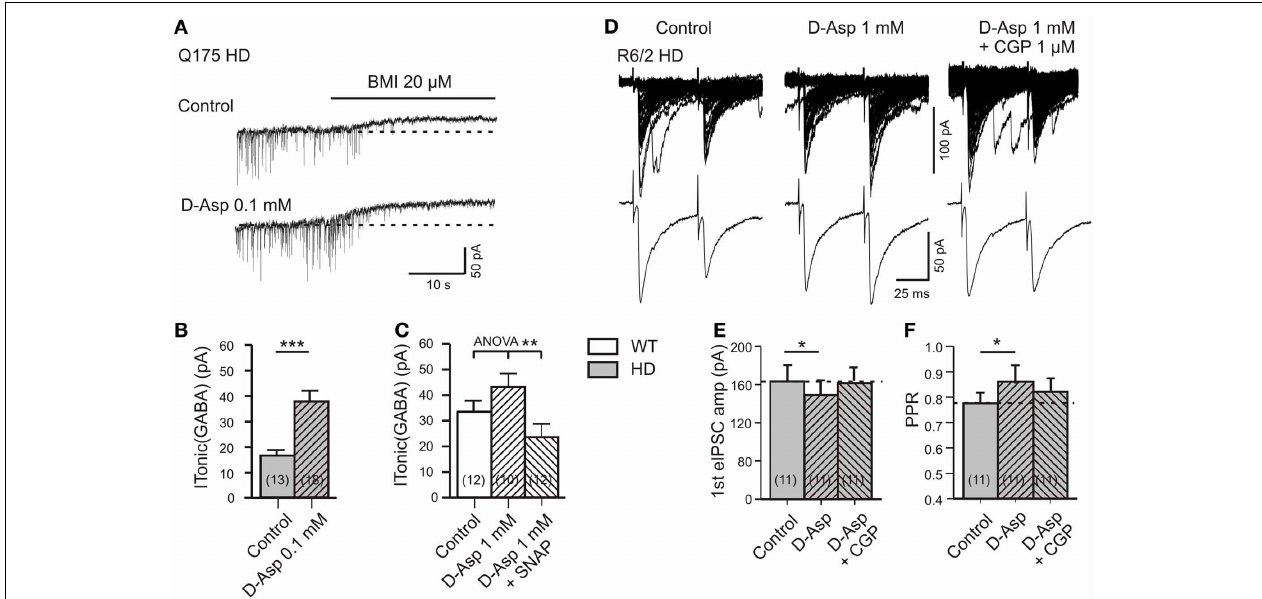
in the three columns are independent, not matched. (D–F) eIPSCs in R6/2 WT and HD SONs in the presence of APV (50 µ M), DNQX (20 µ M), and LY341494 (40 µ M). (D) Records of averaged eIPSCs from one and the same HD SON under the indicated conditions. Note the rescue of tonic GABA(B)-mediated depressionofsynapticGABAreleaseinHDaftertreatmentof1mMD-aspartate for5min. (E,F) QuantificationoftheresultsfromHDSONstestedforchangesin eIPSCamplitude (E) andPPR (F) inthepresenceofD-aspartateandD-aspartate plus CGP. The indicated differences between Control and D-aspartate reflect the amount of tonic presynaptic depression of synaptic GABA release according to Wilcoxon’s matched-pairs signed rank test after Bonferroni correction for multiple comparison. ∗ p < 0 . 05, ∗∗ p < 0 . 01, and ∗∗∗ p < 0 .